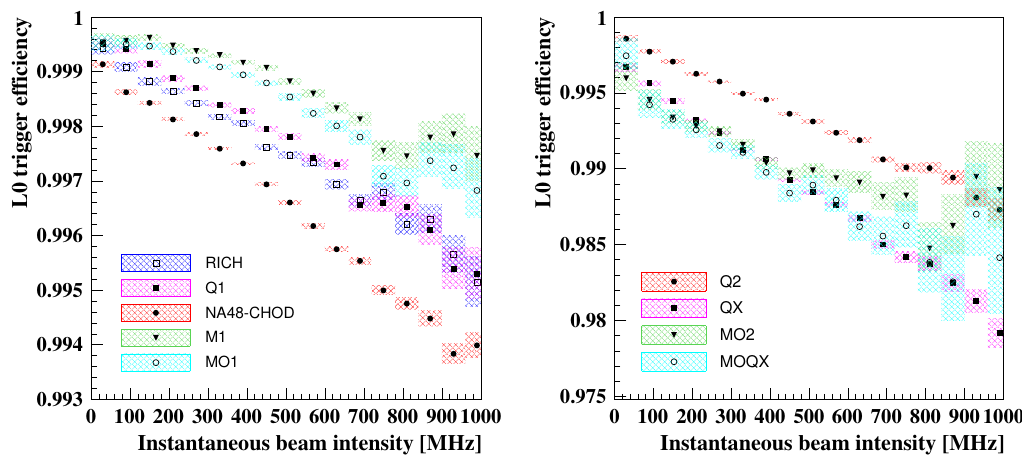
Figure 7. Efficiencies of the L0 trigger conditions measured as a function of the instantaneous beam intensity using a sample of K + → π + π + π − decays. The hatched areas indicate the statistical uncertainties of the